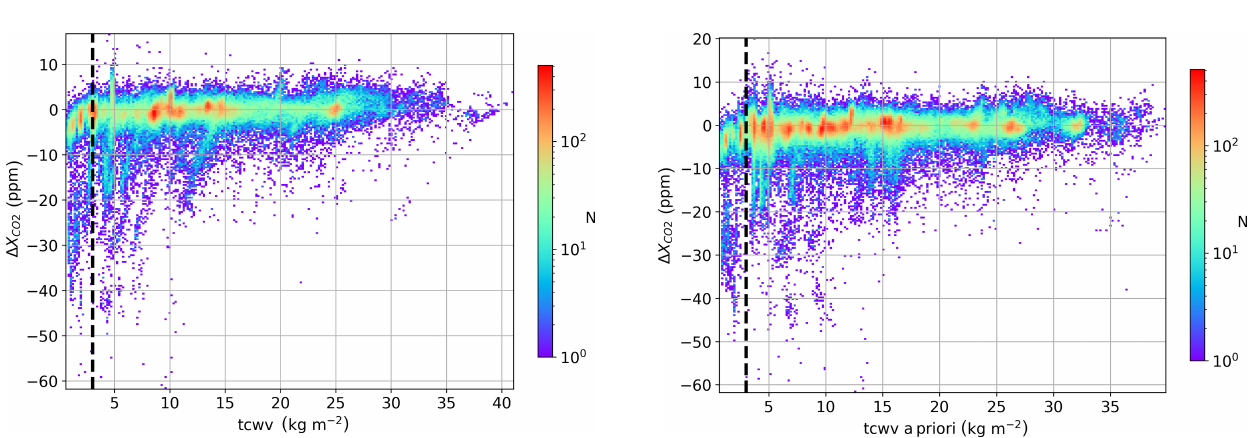
≡ OCO- ( (cid:49)X CO 2 2